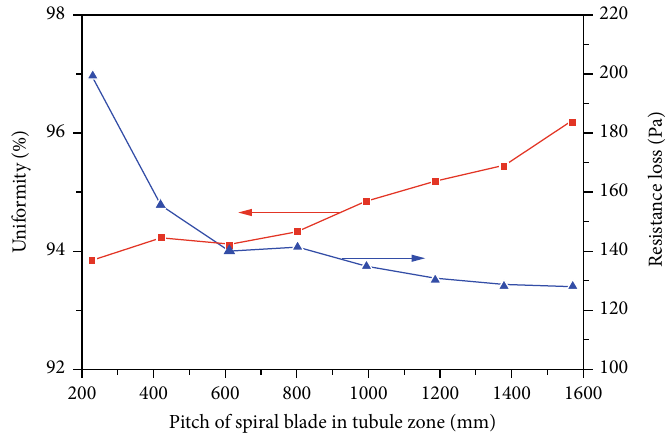
Figure 14: In fl uence of blade pitch on fl ow parameters in small